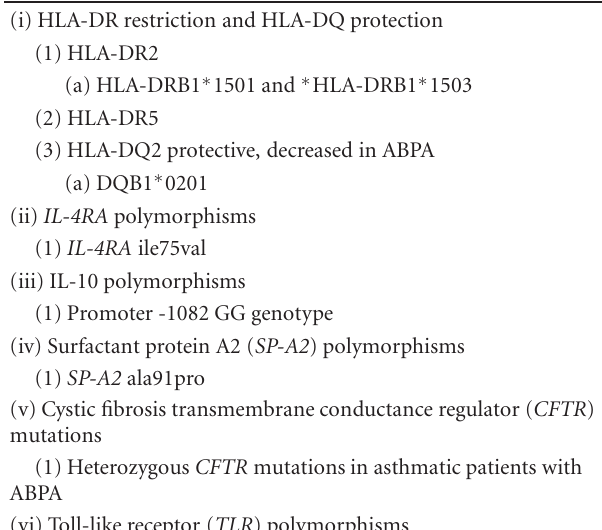
Table 4: Genetic risk factors in the development of allergic bron- chopulmonary